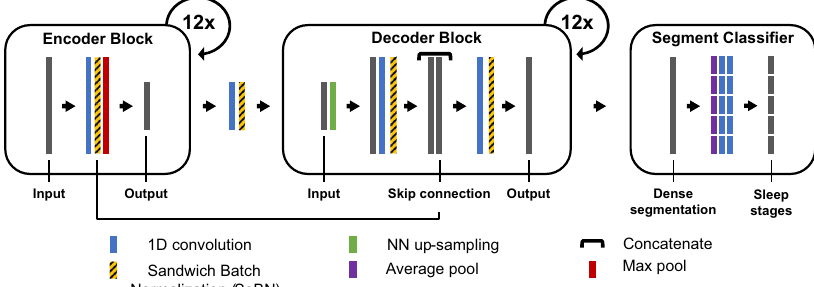
Fig. 1 U-Sleep overall architecture. U-Sleep is a fully convolutional deep neural network. It takes as input a sequence of length L of 30- second sleep epochs and it outputs the predicted sleep stage for each epoch. We slightly modi fi ed the original fi gure (see Figure 2: Model architecture in 11 ) reporting the additional SaBN layers exploited in the conditional learning procedure (see subsection Conditional learning). Please refer to 11 for details on the U-Sleep model architecture and training